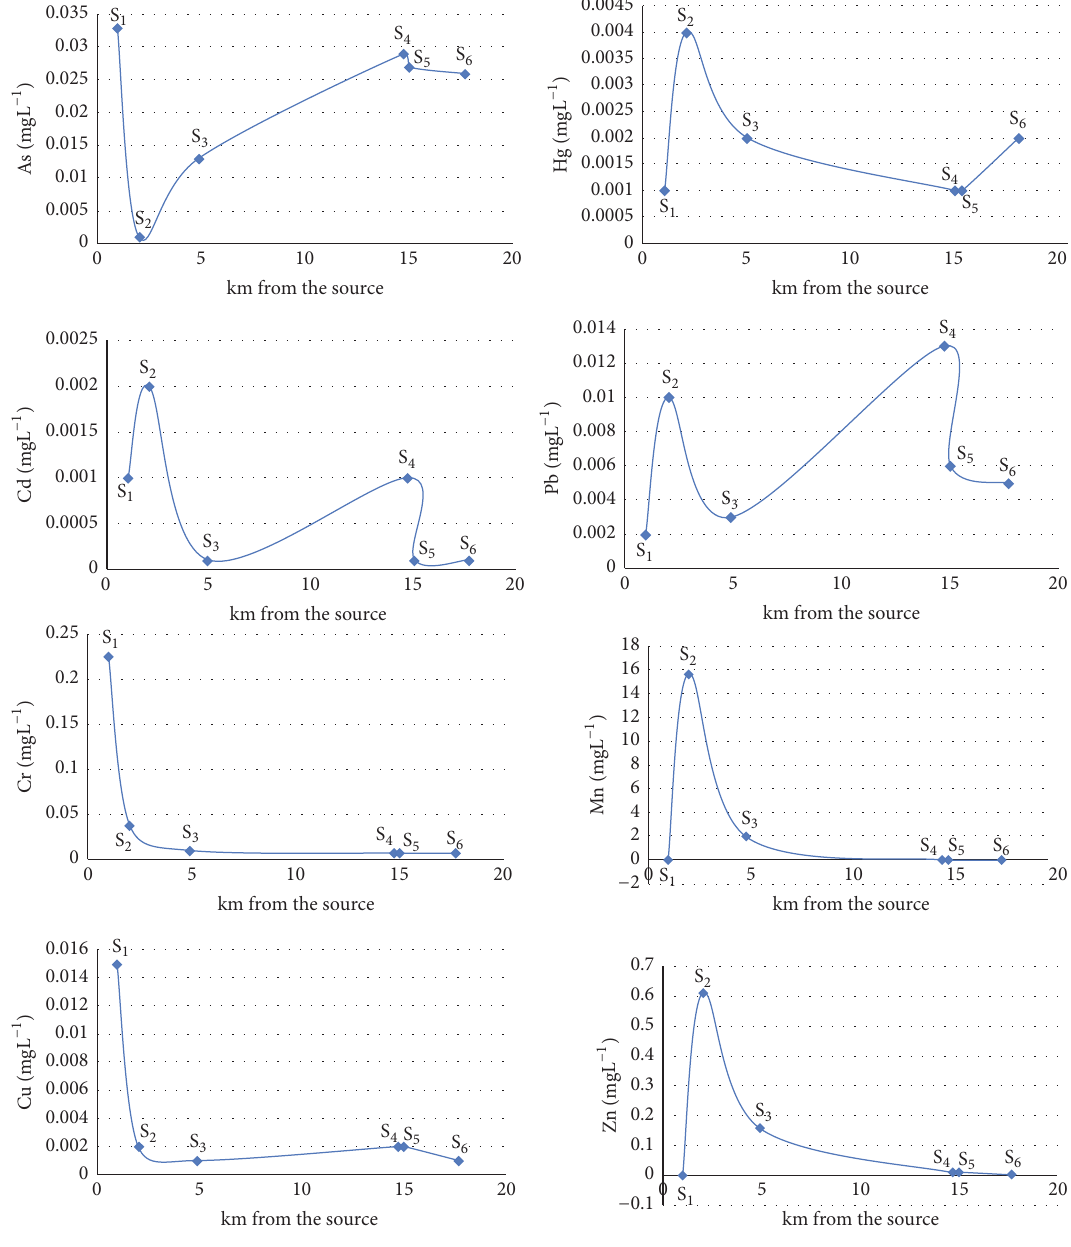
Figure 3: Downstream distribution of selected heavy metals in water of Grac¸anica River versus flow direction in